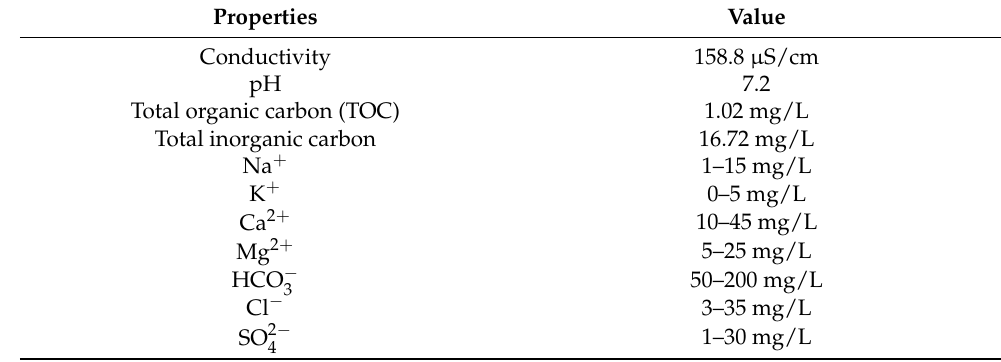
Table 4. The properties of bottled